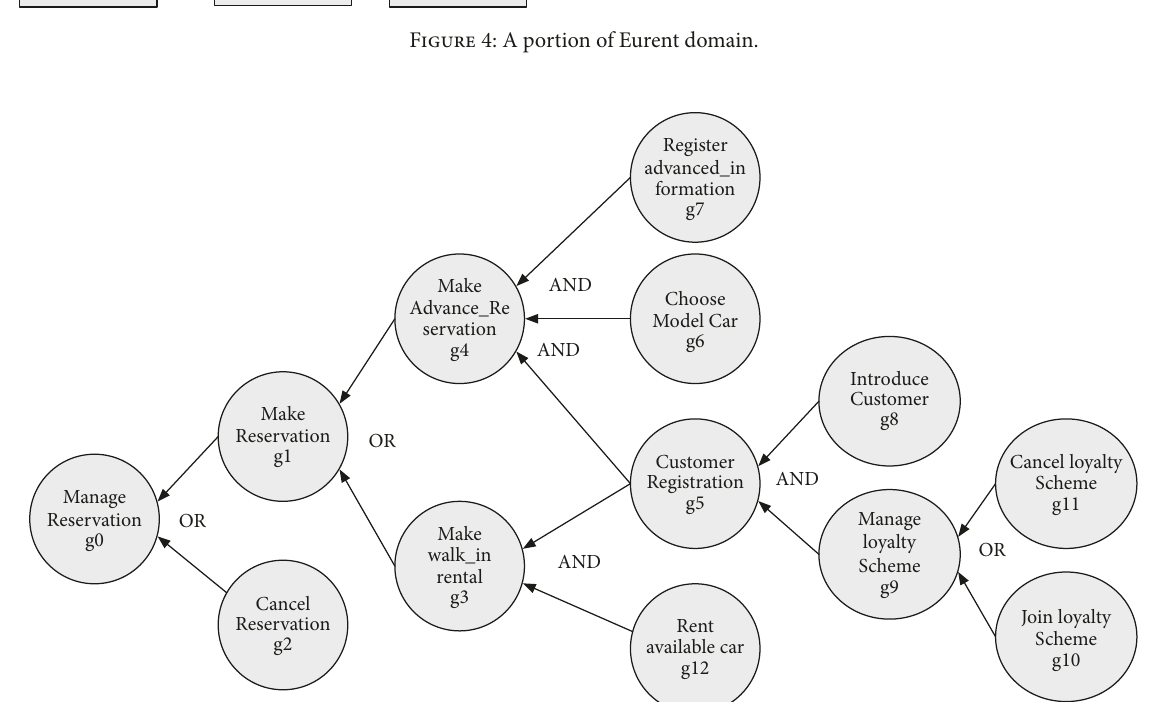
Figure 4: A portion of Eurent domain.